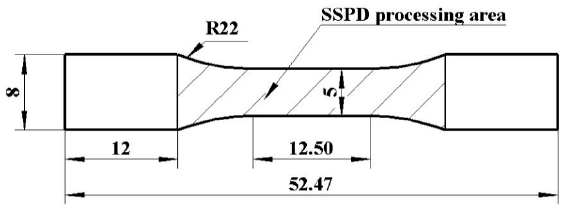
Figure 2. Sketch of tensile specimen (unit: mm).